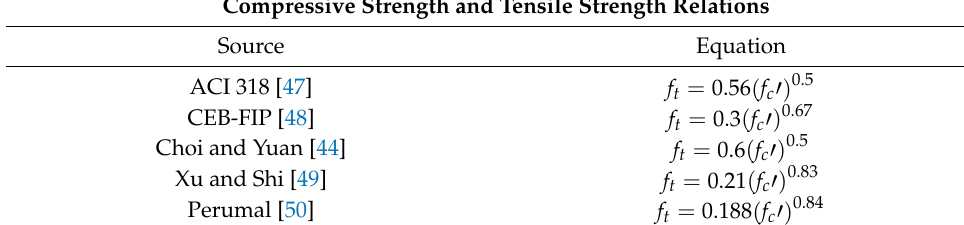
Table 9. Normal concrete equation from past